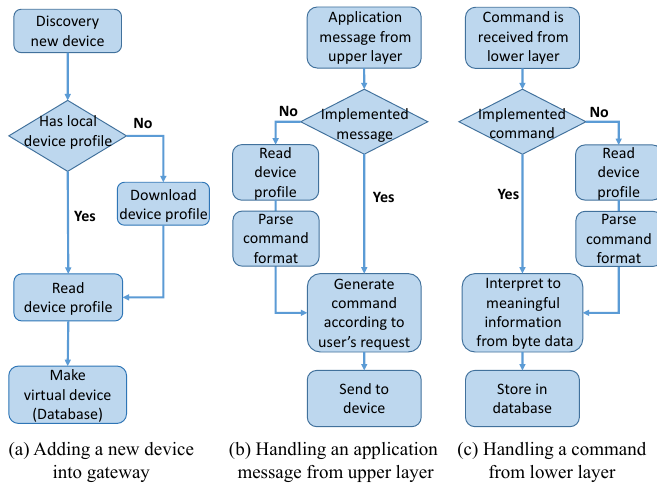
Figure 3. Process flow of the gateway for three cases: ( a ) adding new device to the gateway, ( b ) handling a command from an upper layer, and ( c ) handling a command from a lower